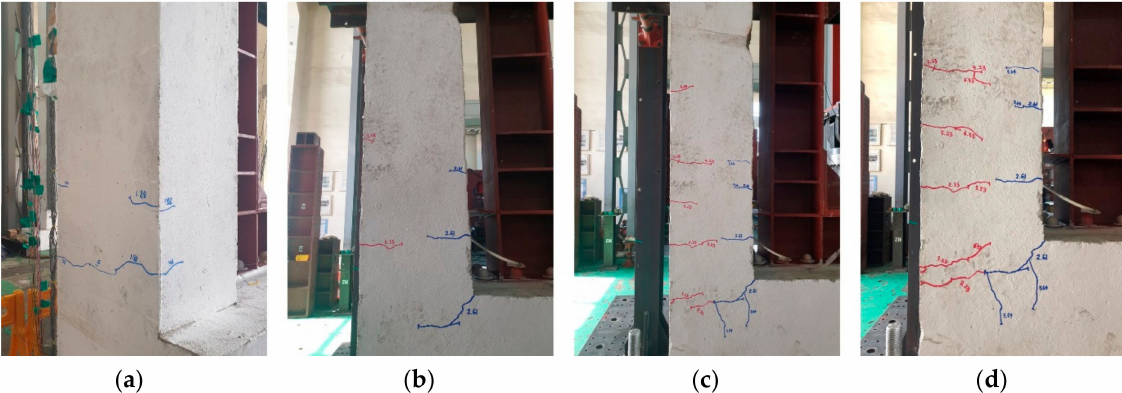
Figure 16. Cracks and ultimate state of test frame retrofitted with NBSD-WSCS (PD-NBSD-WSCS) (200 cm/s 2 ): ( a ) flexural cracks at around 1.88 s (3.5 mm), ( b ) flexural cracks at around 2.61 s (12.7 mm), ( c ) flexural cracks at around 6.33 s (23.9 mm), and ( d ) patterns at the final stage (10 s).